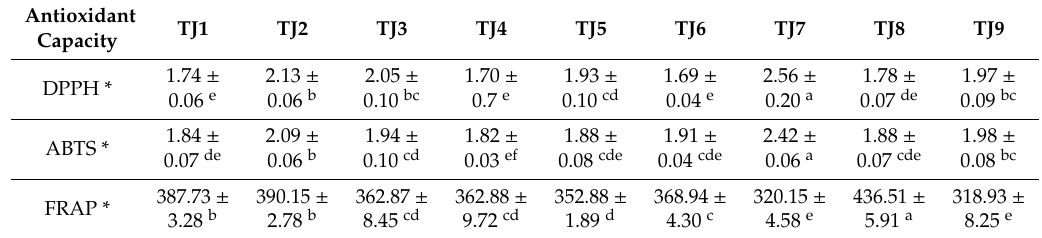
Table 4. Antioxidant activities in di ff erent